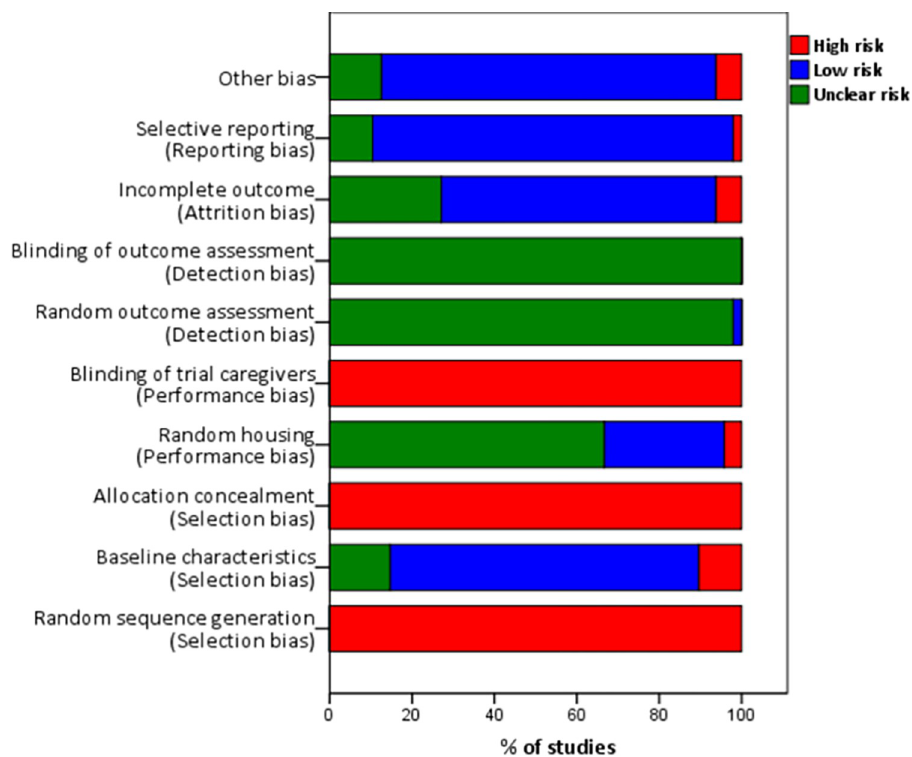
Fig 2. Risk of bias in included studies using the SYRCLEs risk of bias